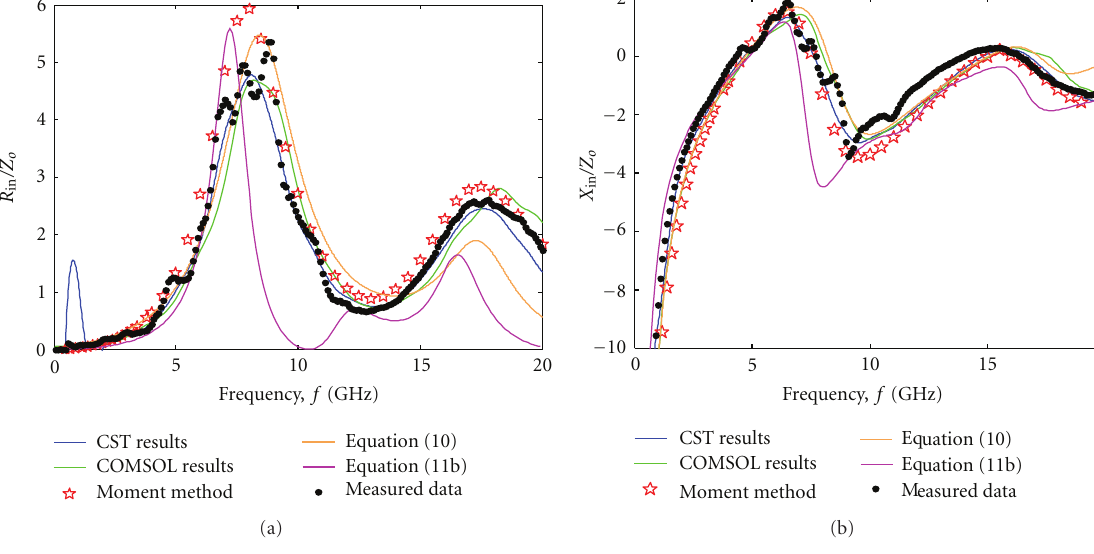
Figure 7: Comparison of (a) normalized resistance, R in /Z o , and (b) normalized reactance, X in /Z o , for air at 25 ◦ C by considering size of monopole driving from coaxial line with a = 0 . 65mm, b = 2 . 05 mm, and h = 14 . 32